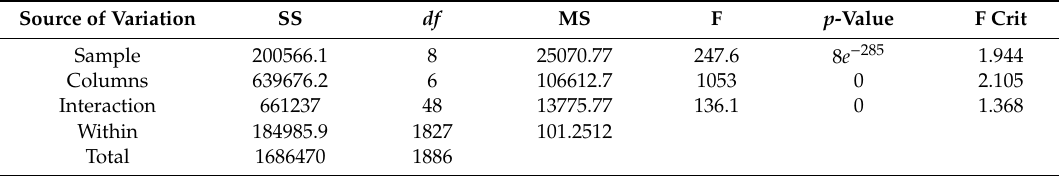
Table 10. ANOVA for Q1, Q2, Q3 and Q4